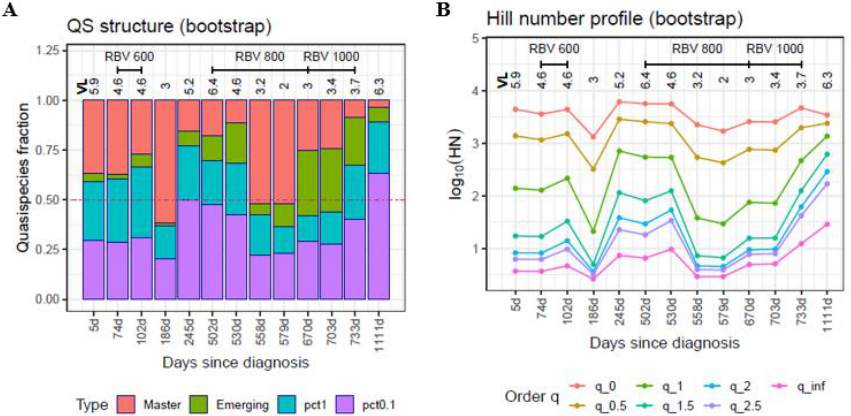
Figure 3. QFF ( A ) and HNP ( B ) plots for the HEV patient follow-up. The HNP is plotted here as cross-sections of the profile at given q values. Each line corresponds to a q value; the lines show how this value changes over time. Bootstrap values are represented. On the x-axis, days since the diagnosis for each sample. Coverage range: 53,307–503,770 reads; median 328,271 reads.